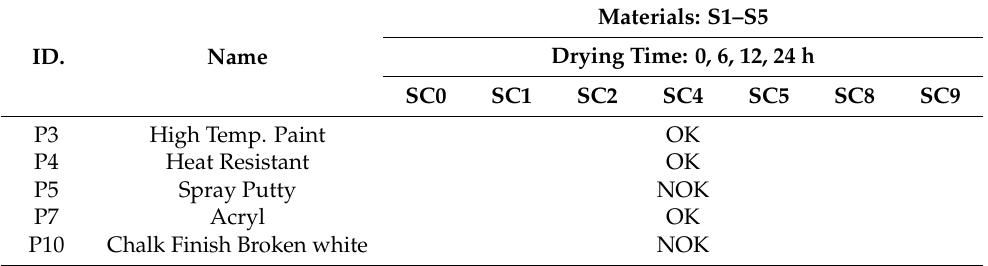
Table 9. Results of the bending test.